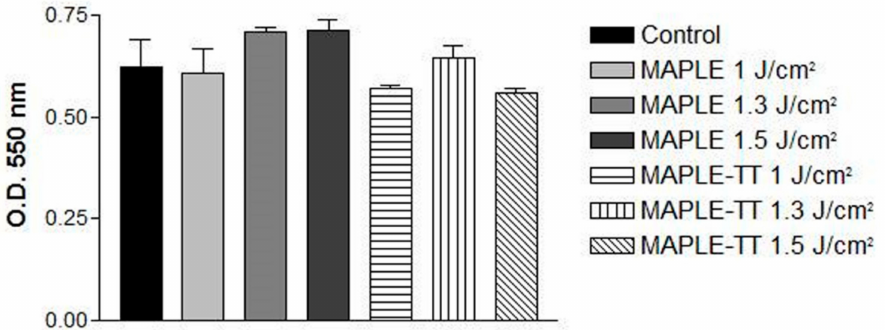
Figure 7. Cell viability of MC3T3-E1 cells assessed by MTT assay after 24 h of culture onto di ff erent MAPLE and MAPLE TT-deposited PVDF materials. Results are presented as mean ± standard deviation (SD) ( n =